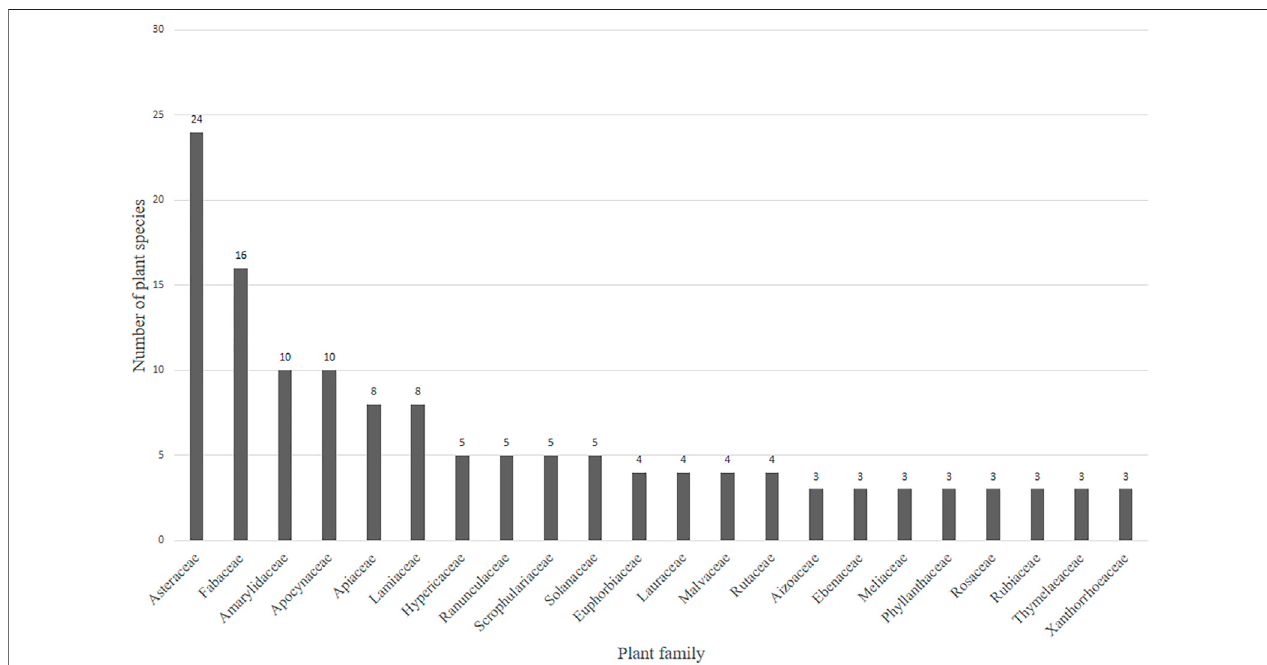
FIGURE 4 | Twenty-two plant families with three or more plant species recorded for the treatment of depression. In total, 63 plant families representing 186 plants were recorded in Supplementary Table S1 . The remaining 41 families had only one or two plants. Thirty plant families were recorded in Table 2 as representing a narrowed-down 54 popular medicinal